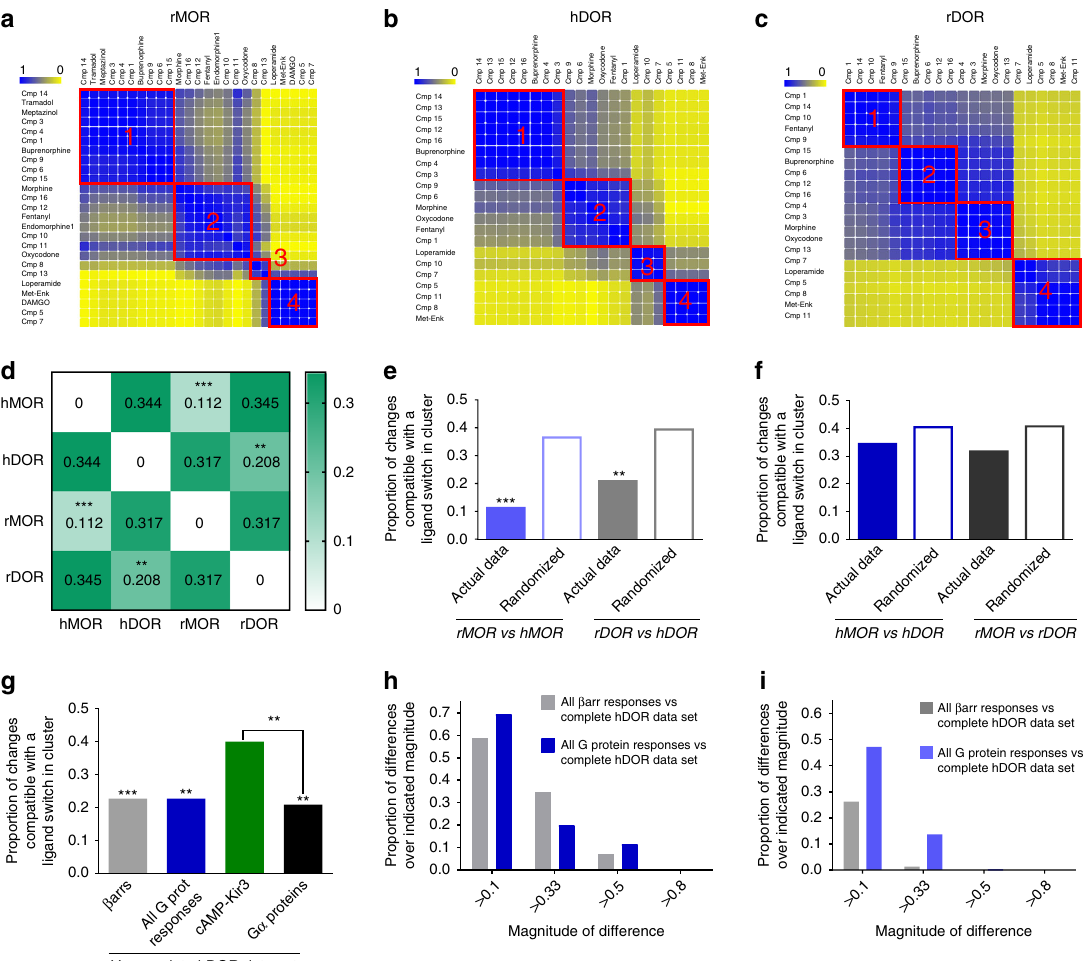
Fig. 5 Signaling pro fi les of opioid receptor ligands are conserved across species but not receptor subtypes. Ligand similarity heatmaps for rat MOR ( a ), human DOR ( b ), and rat DOR ( c ) data sets. Yellow and blue, respectively, indicate ligands/parameters that never or always cluster together. Proportion of ligands changing cluster for indicated comparisons; ** p < 0.01, *** p < 0.001 comparing actual to randomized data sets as in Fig. 3 ( d ). Similarity matrices for the same receptor compared across species. Filled and empty bars: proportion of ligands changing clusters when, respectively, comparing actual data and random clustering simulations to the reference matrix; ** p < 0.01, *** p < 0.001; z -score MOR subtypes: − 7.153; z -score DOR subtypes: − 2.742 ( e ). Similarity matrices for receptor subtypes within species compared as in ( e ). Actual and randomized data sets did not differ: z -score hMOR vs. hDOR: − 1.502; z -score rMOR vs. rDOR subtypes: − 1.567 ( f ). Similarity matrices for β arr- or G protein-partial data sets were compared with the complete hDOR matrix as in ( e ); only comparisons for actual data are shown; ** p < 0.01, *** p < 0.001; z -scores versus corresponding randomized data: β arr: − 3.309; G protein: − 2.644; cAMP-Kir3.2: − 0.309, G α proteins: − 3.286. ## p < 0.01; z- score difference: cAMP-Kir3.2 vs. G α proteins: 2.515. p = 0.256; z -score difference β arrs vs. All G prot responses: − 0.656 ( g ). A difference was calculated between every value ij in the complete hDOR matrix and corresponding value ij in indicated partial data sets. Histogram shows the fraction of differences with absolute value above indicated thresholds ( h ). Calculations described in ( h ) were repeated for the complete hMOR matrix and partial data sets for β arr or G protein ( i ). Source data provided in Supplementary Data 7, 8, and 9 and source data fi les and k-means to reveal four different drug categories (Fig. 6a). Cluster #1, including isoproterenol (ISO) and norepinephrine (NE), was characterized by measurable agonist ef fi cacy at all readouts. Salbutamol (SALB) and salmeterol (SALM) in cluster #2 could be distinguished from the fi rst category because of their minimal responses at β arr-dependent readouts. Carvedilol (CARV) and propranolol (PRO) behaved as agonists only in the ERK pathway (Cluster #3), while ICI118,555 and metoprolol (MET) had no ef fi cacy except for inverse agonism at G α s Ca 2 + mobilization) 48 , (b) β arr-mediated responses ( β arr2 recruit- and cAMP assays (cluster #4). The complete signaling pro fi les for ligands in different clusters are provided in Supplementary multifaceted response involving both G proteins and β arrs 49 . Fig. 14. As shown in Fig. 6b, partial data sets for G α s/cAMP/Ca 2 + and for β arr-recruitment/endocytosis recreated original clusters better the readouts (Supplementary Data 10) were analyzed by NNMF NATURE COMMUNICATIONS| (2019)10:4075|https://doi.org/10.1038/s41467-019-11875-6|www.nature.com/naturecommunications